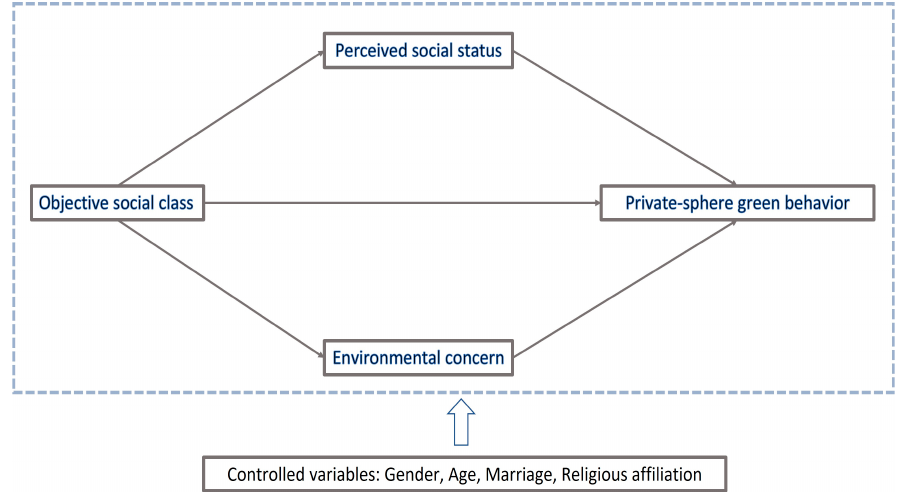
Figure 1. Conceptual framework of social class and private-sphere green